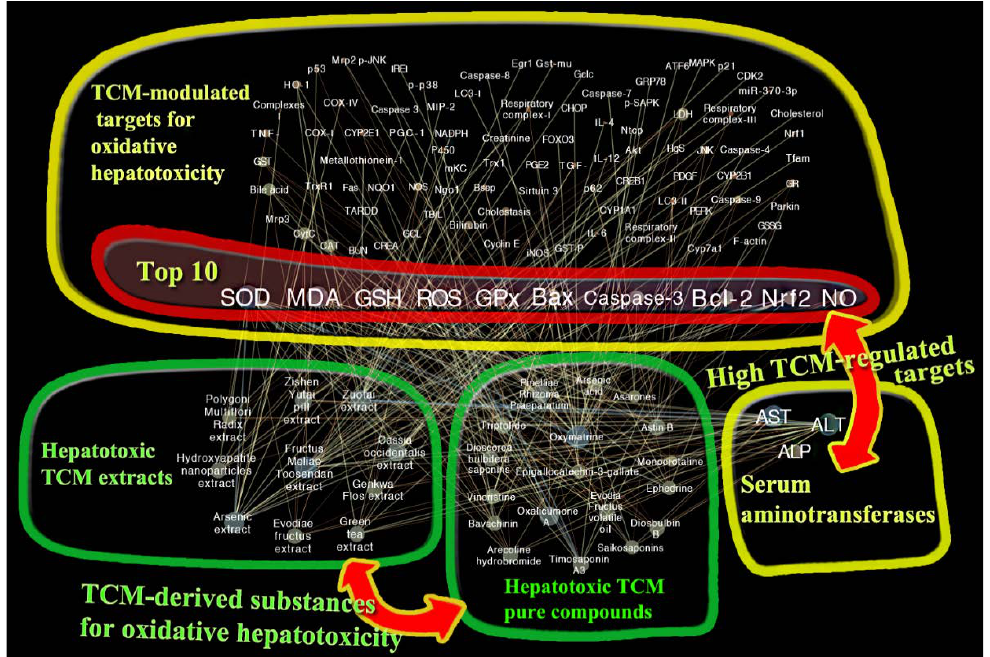
Figure 2. Network pharmacology-based target identification of TCM-derived natural compounds or extracts for the generation of oxidative hepatotoxicity.